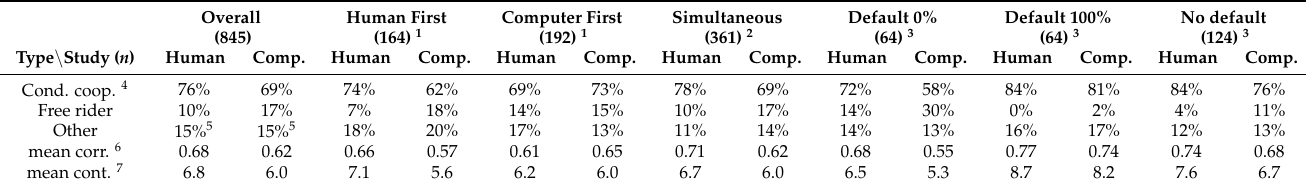
Table 1. Summary